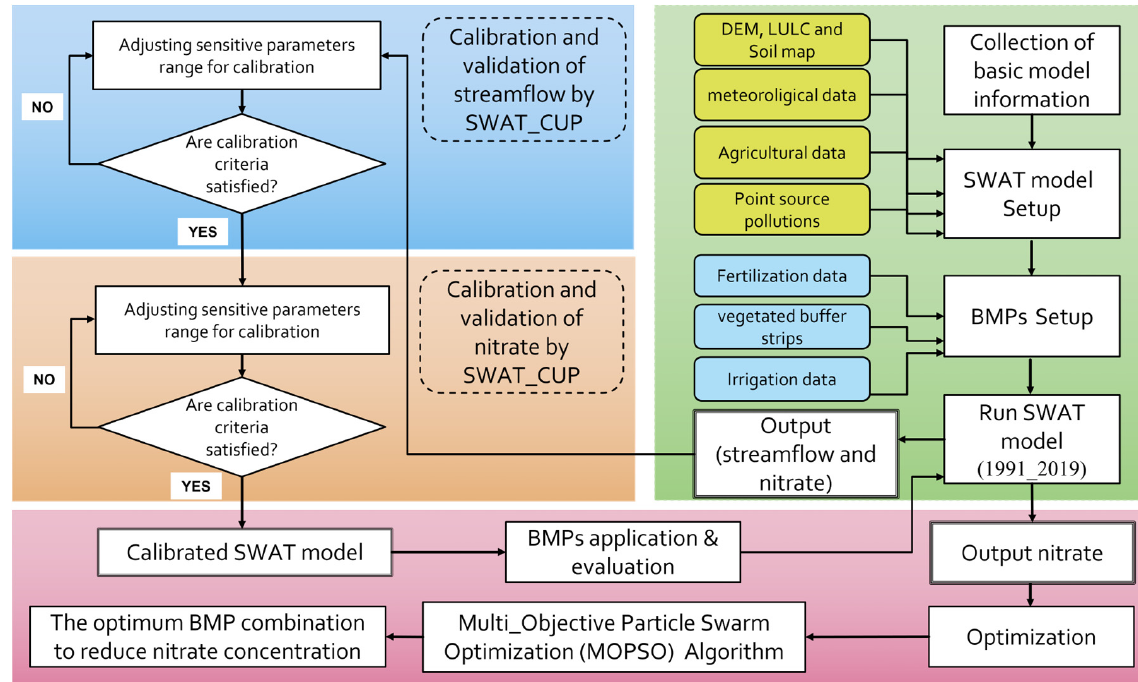
Figure 3. Schematic representation of the proposed methodology.